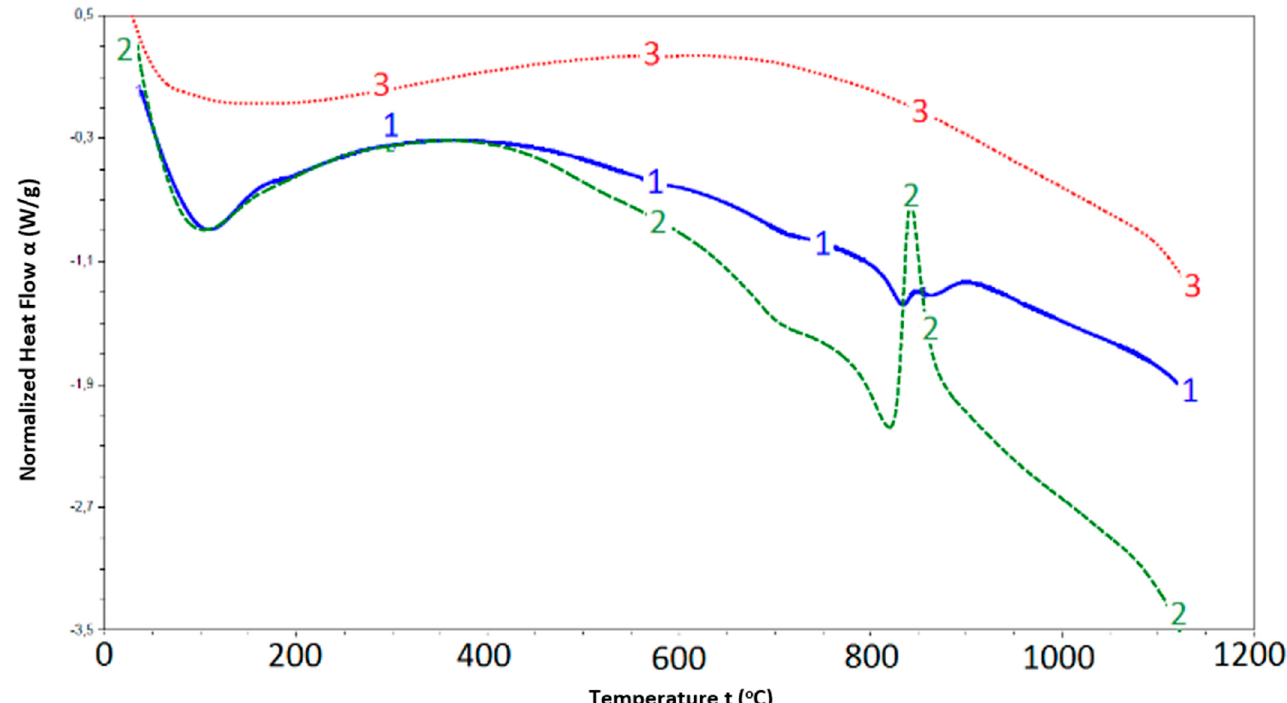
Figure 3. Thermal analysis of samples: 1—mechanically activated SCM; 2—mechanically activated SCM mixed with water; 3—mechanically activated and thermo-modified (850 ◦ C) SCM.